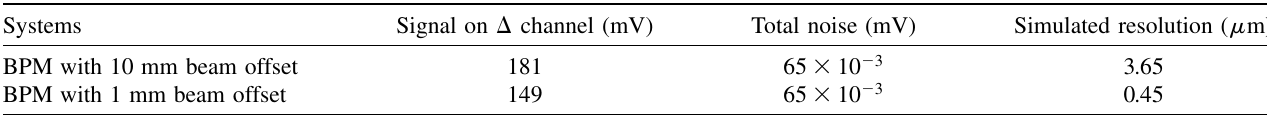
TABLE II. Signal and noise level calculated for the reentrant